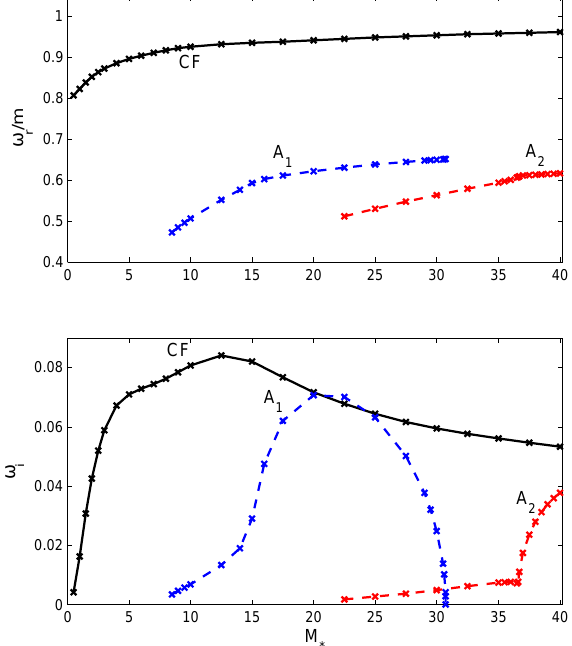
Figure 3. Calculated eigenvalues of the main unstable branches depending on the parameter M * in the model gas disk, having ro- tation profile (7), (8) with parameters (10), but α = −2.0. Case Ω min of uniform unperturbed surface density. Top panel – phase angular velocity of waves ω / m , bottom panel – increment ω r i